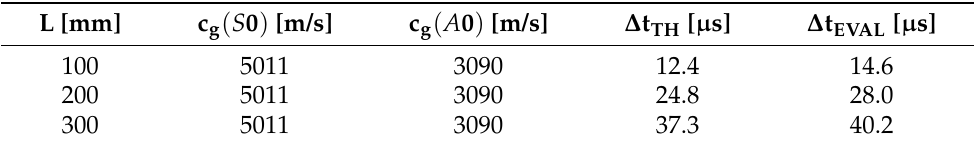
Figure 7. Detail of the recovered signals of FOS during PLB tests on the HEM220 beam: ( a ) 100 mm distance, ( b ) 200 mm distance, and ( c ) 300 mm distance. Table 1. The theoretical and measured ∆ t between the S 0 and A 0 times of arrival, for the 100, 200, and 300 mm